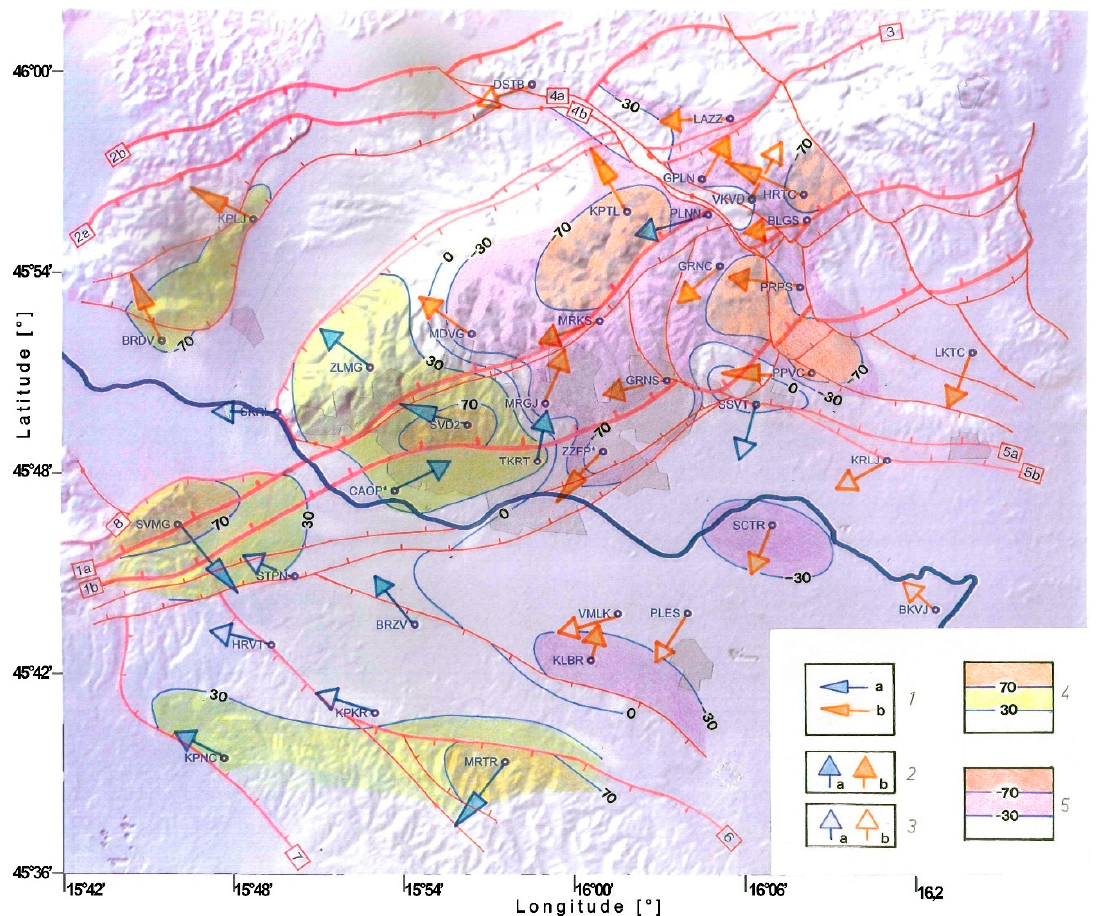
Figure 15. Tilt angles and directions of tectonic movements based on GPS data for the period 1997–2015; 1a —positive spatial (elevation/uplift) and 1b —negative movement (descent) under the angle higher than 70° (prevailing of vertical movement component); 2a —positive spatial (elevation/uplift) and 2b —negative movements (descent) with an angle between 30° and 70°; 3a —positive spatial (elevation/uplift) and 3b —negative movements (descent) with an angle less than 30° (prevailing of horizontal movement component).